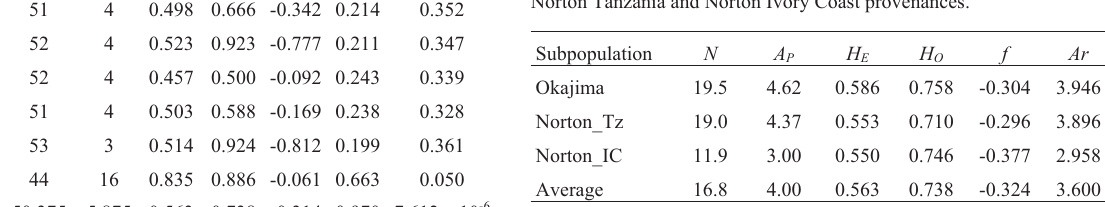
Table 3 - Genetic diversity estimates ( Ap, H E , H O and Ar ) and intra- population fixation index ( f ) based on eight SSR markers for Okajima, Norton Tanzania and Norton Ivory Coast